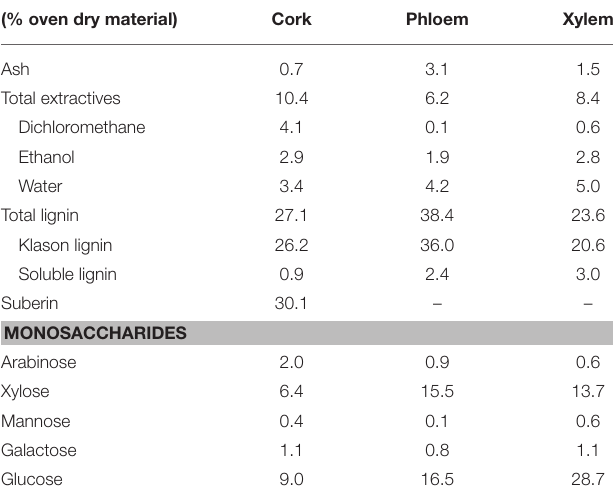
TABLE 1 | Chemical composition of the 40–60 mesh from cork, phloem and xylem of Quercus suber L. Mean values of two